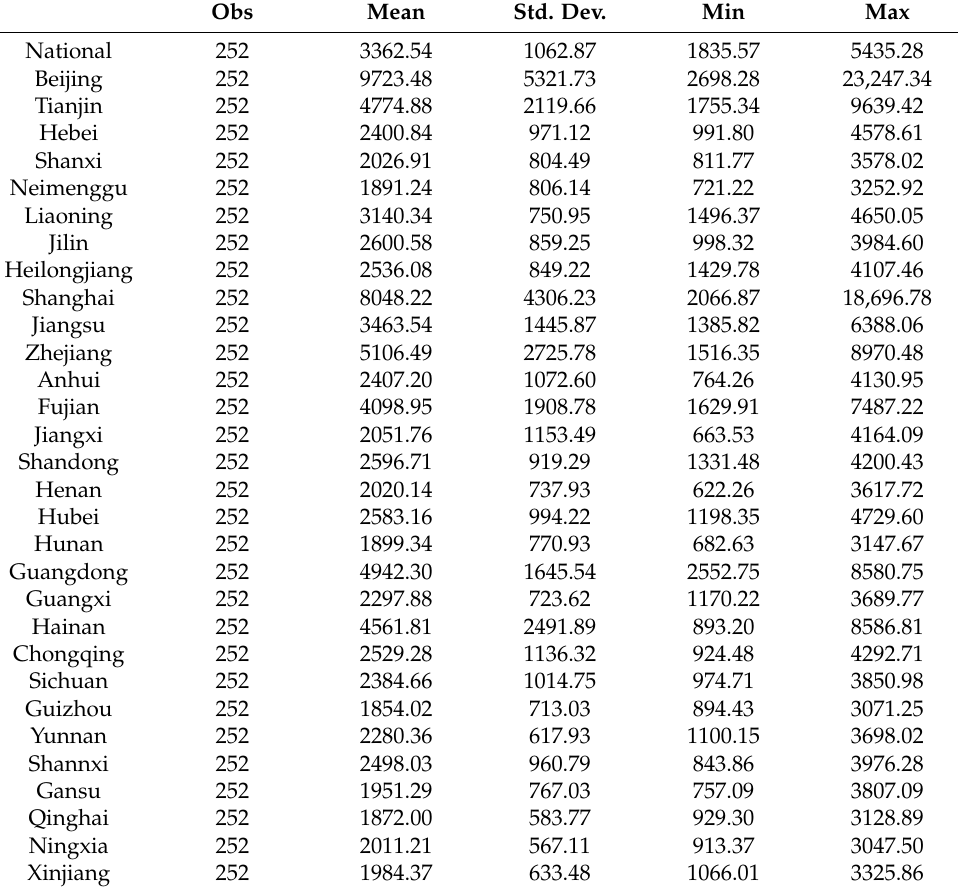
Table 2. Summary statistics of national and regional house